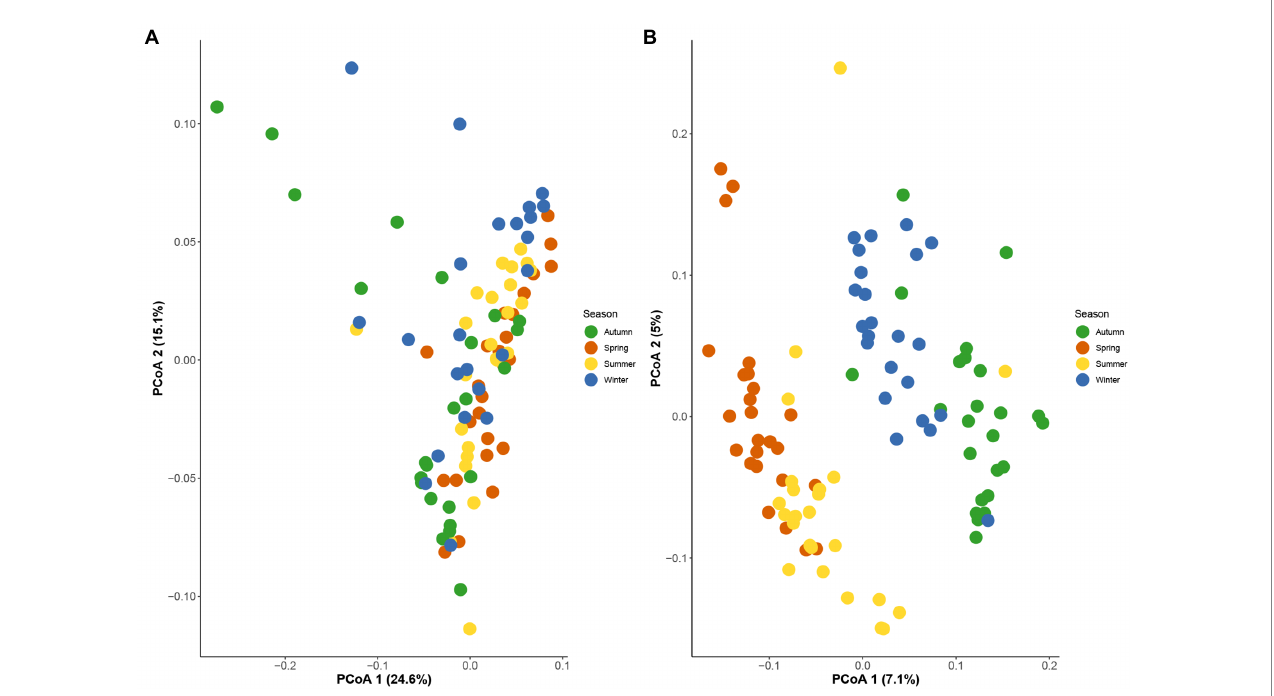
FIGURE 3 Principal co-ordinate analysis based on weighted UniFrac distances (A) and unweighted UniFrac distances (B) between all seasons showed significant difference in structure of seasonal gut microbial